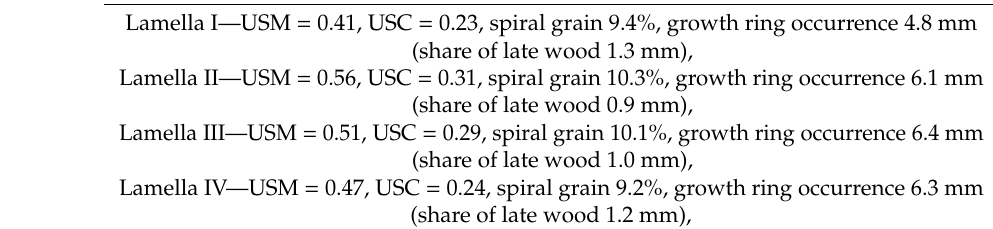
Table 2. Example of description of structural and geometrical features for selected glulam beams (including USC—general knotty rate, USM—marginal knotty rate). Front : healthy oval knot at the edge (lamella I, bases 1, 3, 6, 9, lamella II, base 12, lamella III, base 4), healthy oval knot on the plane (lamella I, bases 5, 8, 13, lamella II, base 3, lamella IV, base 11), degraded knot at the edge (lamella III, base 12, lamella IV, bases 3, 8), deteriorating knot at the edge (lamella IV, base 6), deteriorating knot on the plane (lamella III, base 9), deteriorated knot on the plane (lamella II, bases 9, 13, lamella III, base 7), burls (lamella I, bases 7, 8, lamella III, base 7). NWa-1 Back : healthy oval knot on the plane (lamella I, base 13, lamella III, base 13, lamella I, III, IV, base 4 and 5), resin blister on the plane (length 35 mm, depth 1.8 mm, lamella III, base 9), burls (lamella III, base 7).